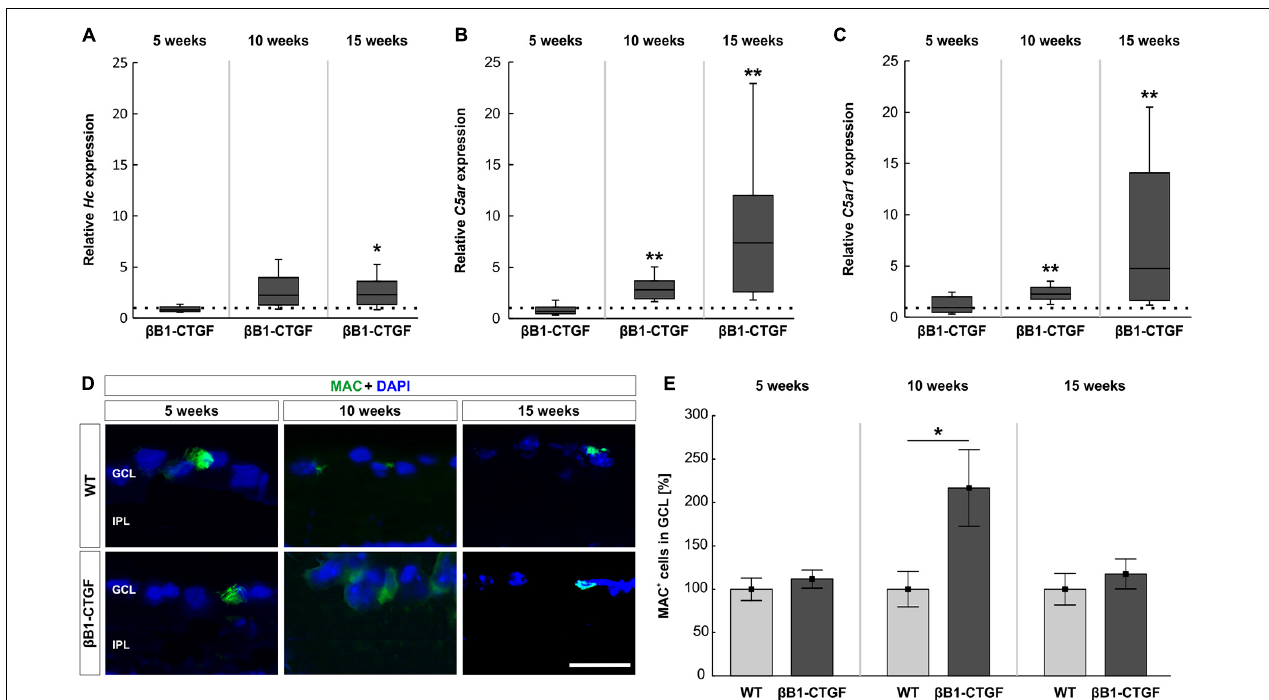
FIGURE 2 | Enhanced terminal pathway components in β B1-CTGF mice. (A) The expression of Hc (C5) mRNA was not altered in transgenic mice at 5 and 10 weeks. At 15 weeks, a significant upregulation of Hc mRNA levels was noted in β B1-CTGF mice ( p = 0.03). (B) RT-qPCR analyses showed no alterations of C5ar (C5a anaphylatoxin receptor) mRNA levels at 5 weeks. In contrast, a significant upregulation of C5ar mRNA expression levels was detected in 10- ( p = 0.001) and 15-week-old β B1-CTGF mice ( p = 0.002). (C) The C5ar1 (complement component C5a receptor 1; CD88) mRNA levels were not altered in 5-week-old transgenic mice, while a significant upregulation was revealed at 10 ( p = 0.007) and 15 weeks ( p = 0.001). (D) An anti-MAC antibody (green) was applied to label retinal cross-sections at 5, 10, and 15 weeks of age. DAPI counterstained cell nuclei (blue). (E) While no changes in the number of MAC + cells were observable at 5 and 15 weeks, a significantly higher number of MAC + cells was noted in 10-week-old transgenic mice ( p = 0.03). Values for RT-qPCR are median ± quartile ± minimum/maximum ( n = 5–7/group). The dotted line in panels (A–C) represents the relative expression of the WT group. Values for immunohistology are mean ± SEM ( n = 7–9/group). GCL, ganglion cell layer; IPL, inner plexiform layer. Scale bar: 20 µ m. * p < 0.05; ** p < 0.001.